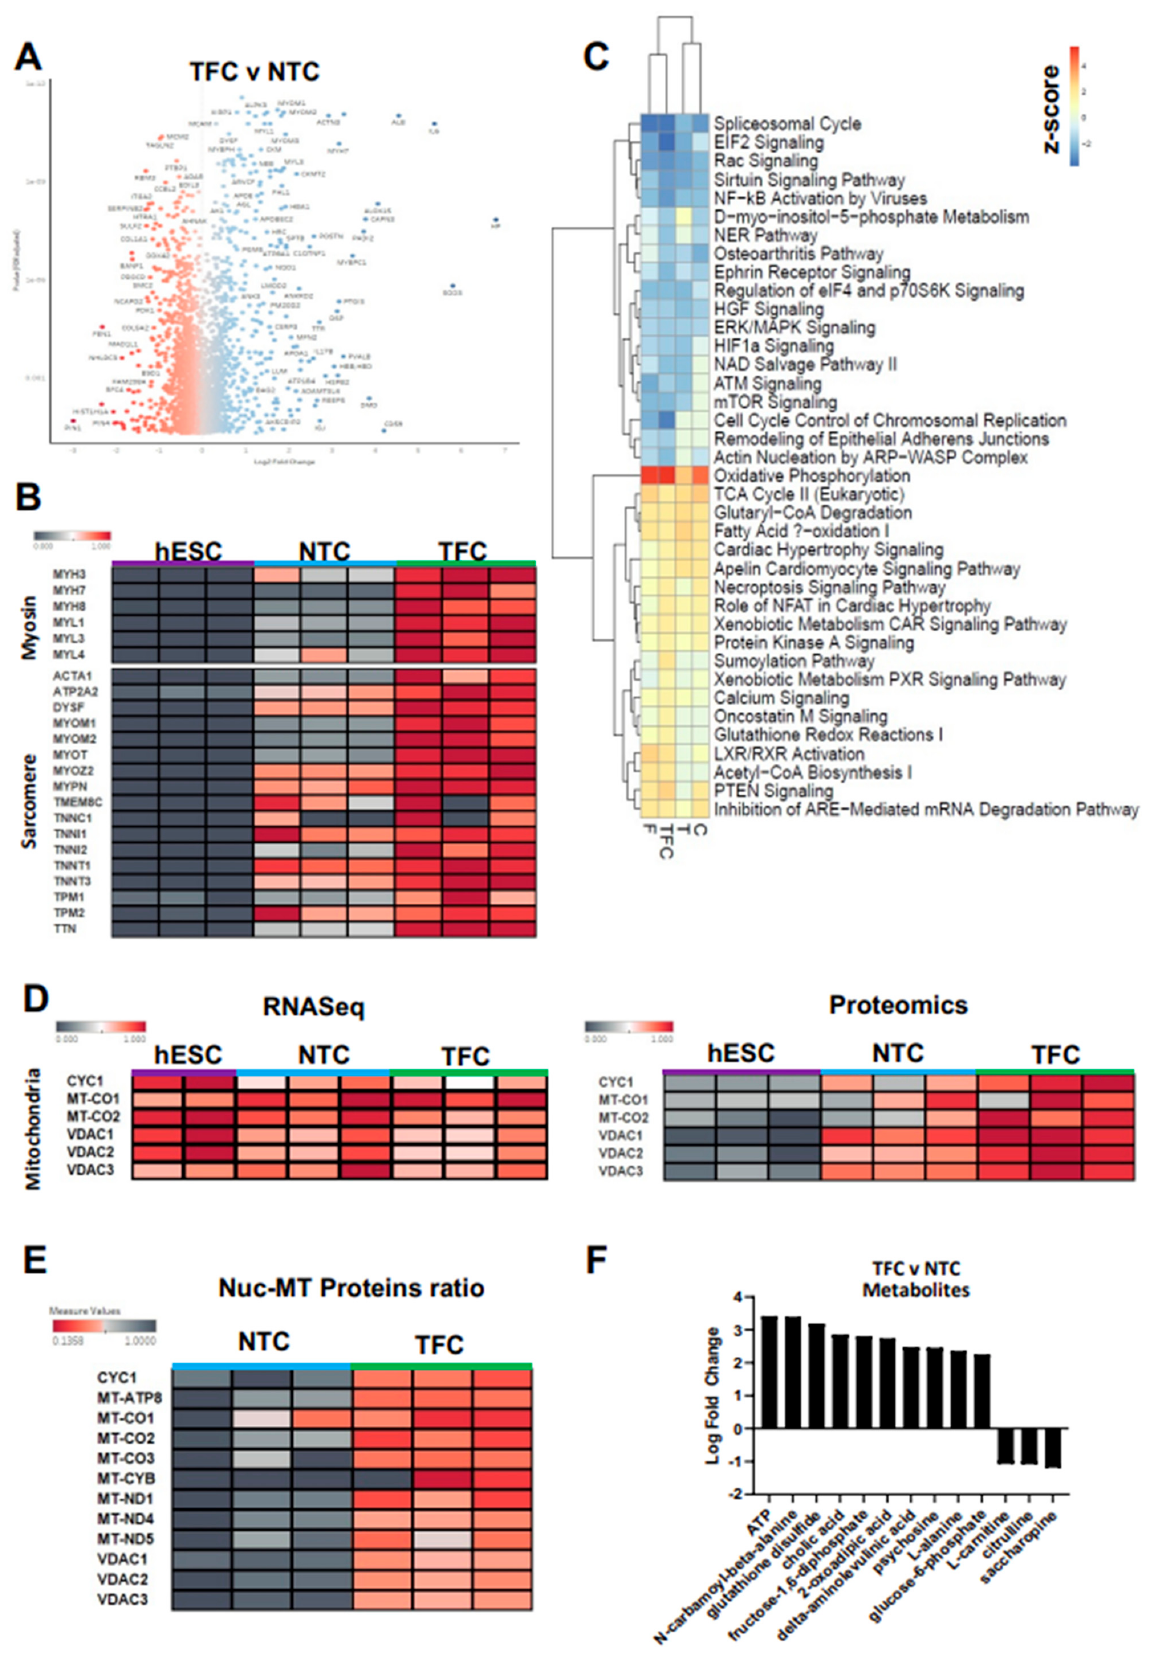
Figure 4. Proteomic profiles of NTC and TFC-treated hESC-SkMCs. ( A ) Volcano plot of differentially expressed proteins between TFC and NTC. ( B ) Heatmap comparison of various myosin and